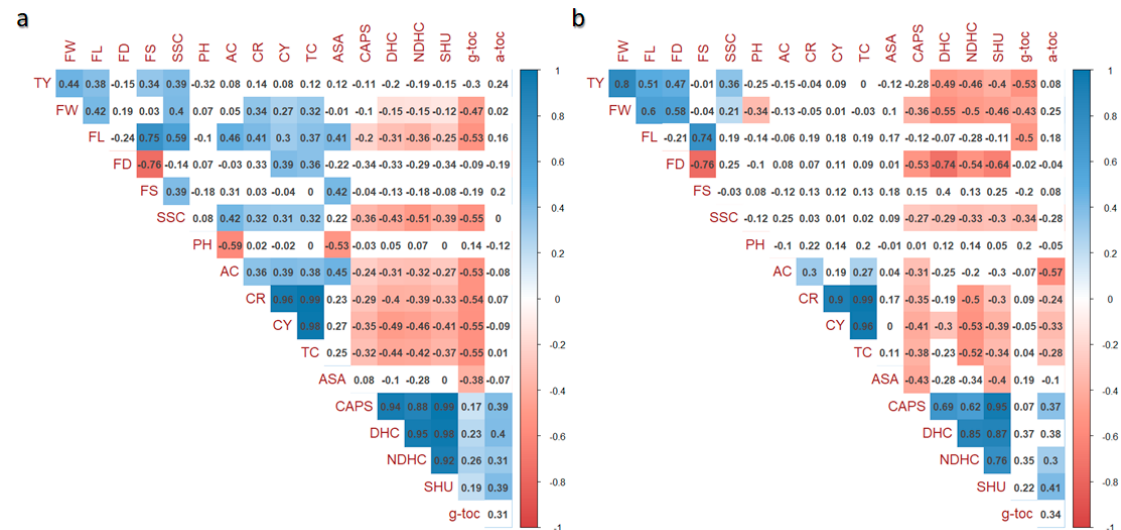
Figure 1. Pearson’s rank correlation coefficients between the pairs of phenotypes. The correlation coefficients are indicated in each cell. Coloured correlations are those with p -values < 0.01. The colour intensity is directly proportional to the coefficients. On the right side of the correlogram, the colour legend shows the correlation coefficients and the corresponding colours. ( a ) The correlogram for the traits scored in BP, ( b ) ML. The trait acronyms are in the method section.